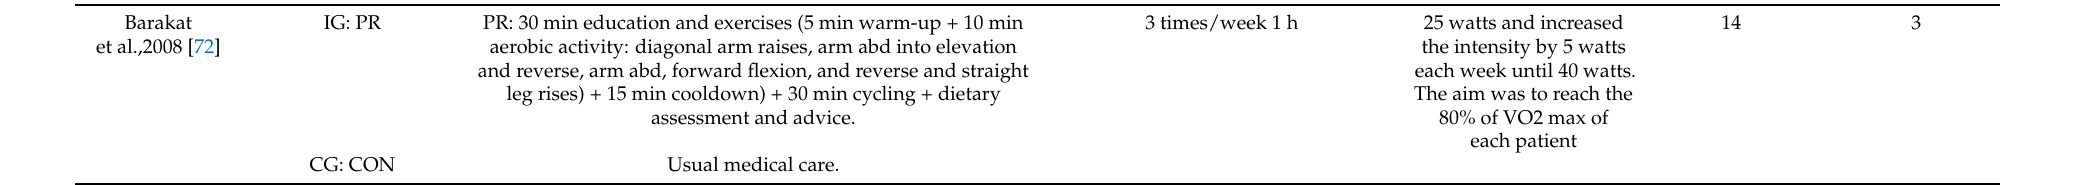
Table 2. Cont. Barakat PR: 30 min education and exercises (5 min warm-up + 10 min et al.,2008 [72] aerobic activity: diagonal arm raises, arm abd into elevation and reverse, arm abd, forward flexion, and reverse and straight leg rises) + 15 min cooldown) + 30 min cycling + dietary assessment and advice. Usual medical